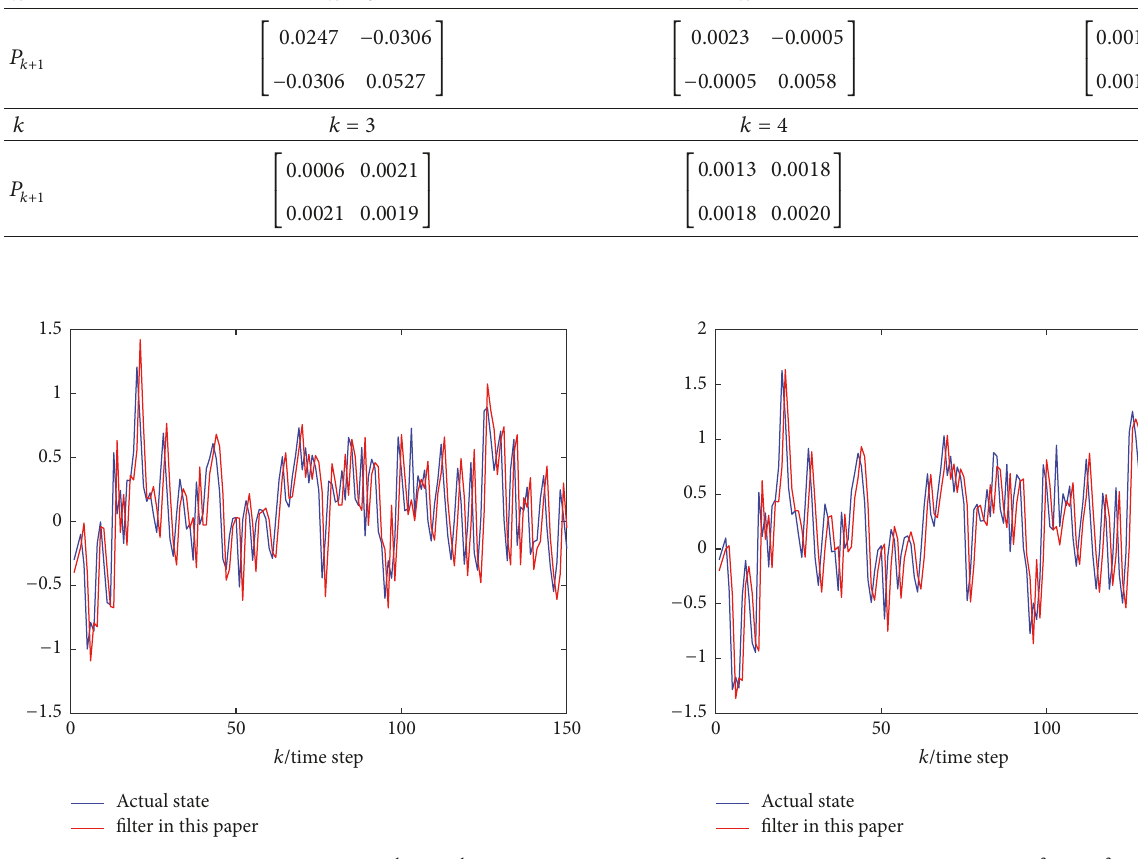
Figure 3: The trajectories of 𝑥 1 𝑘 and ̂𝑥 1 𝑘|𝑘 . Figure 4: The trajectories of 𝑥 2 𝑘 and ̂𝑥 2 𝑘|𝑘